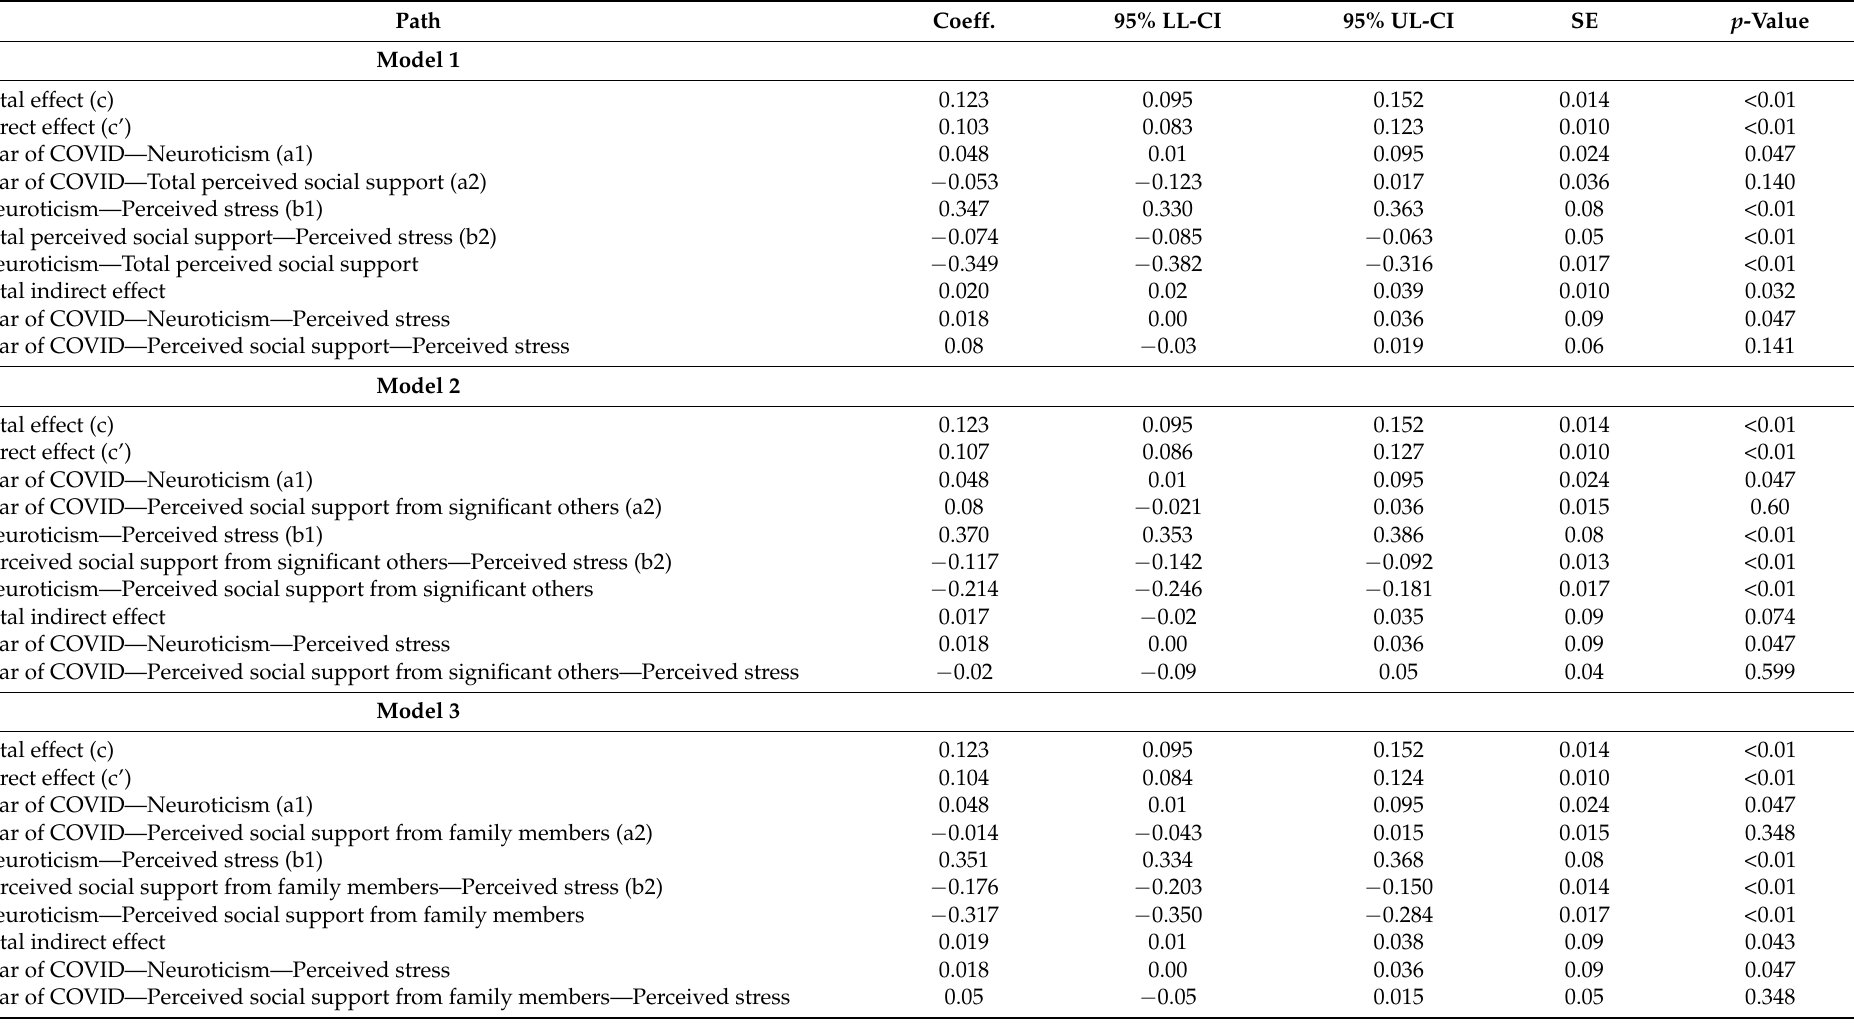
Table 4. Direct, indirect and total effects on fear of COVID-19 concerning perceived stress in four mediation models ( n =